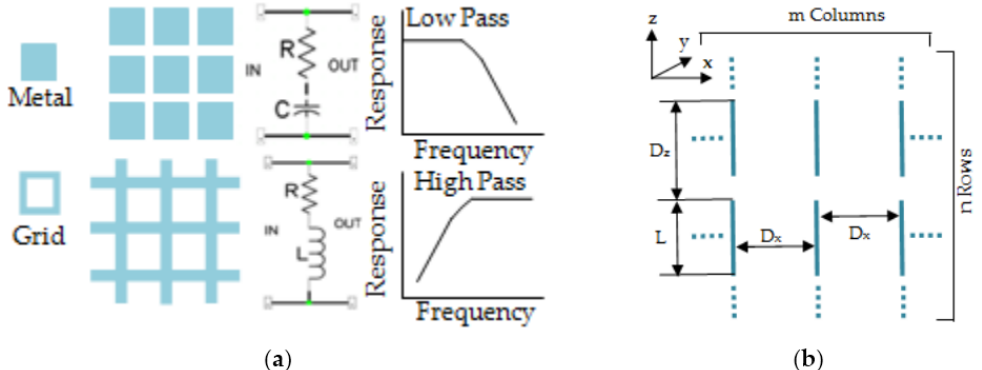
Figure 3. ( a ) FSS periodic structure consisting of complimentary array elements, their equivalent circuits and the frequency responses (Left to right). The patch array element exhibits a capacitive response (low pass), whereas the grid array element shows an inductive response (high pass) [31] ( b ) A true periodic structure showing inter-element spacing (D x and D z ) and element length of